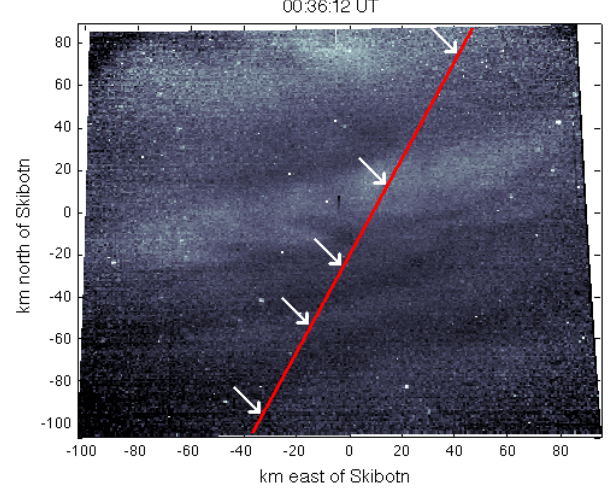
Figure 5. ALIS image (427.8nm) from 5 December 2007 taken from the Skibotn station, projected to an altitude of 110km. The red line marks the Reimei footprint and the white arrows point to the